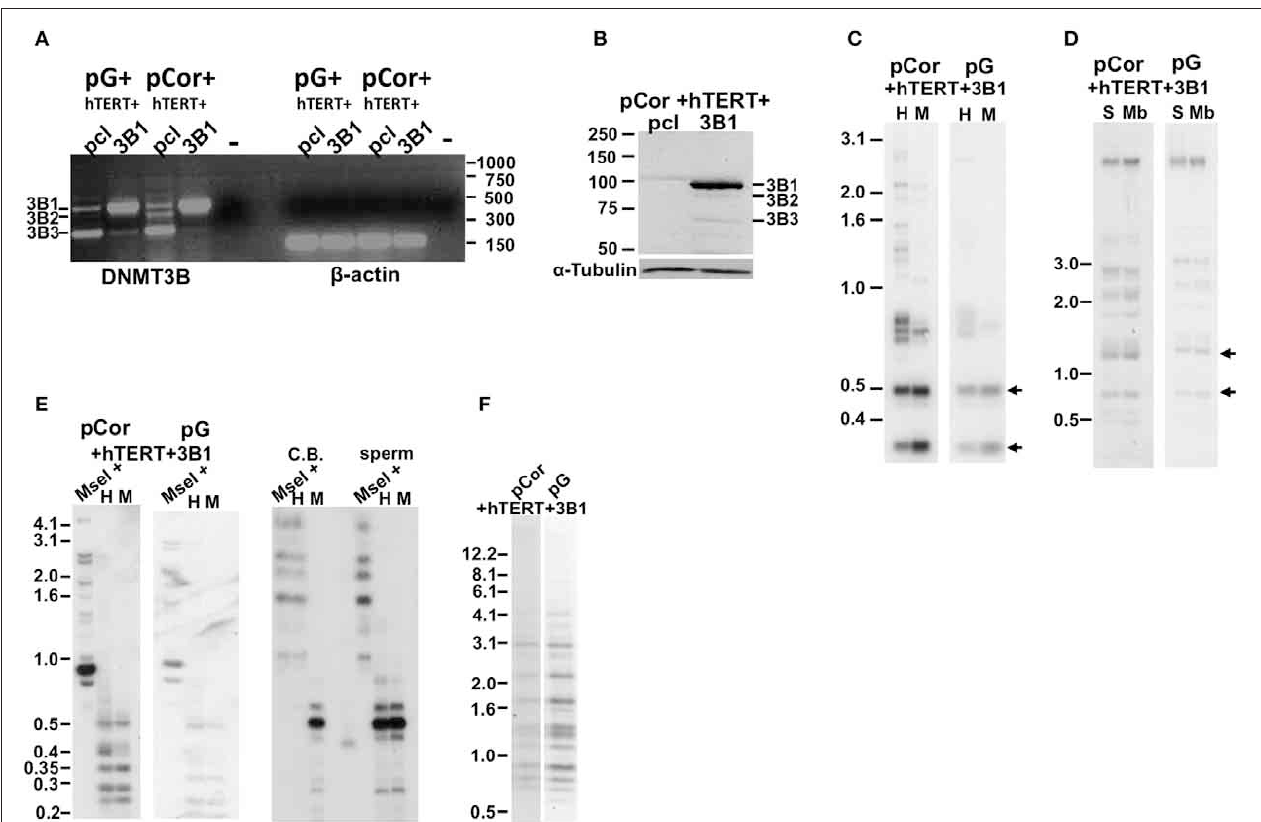
FIGURE 6 | The abnormal methylation state of subtelomeric regions and other non-telomeric repetitive sequences is not rescued by human DNMT3B1 in ICF fibroblasts. (A) RT-PCR analysis of DNMT3B1 mRNA expression in immortalized pG and pCor fibroblasts introduced with either an empty plasmid as a control (pcl) or DNMT3B1 (3B1). DNMT3B has several isoforms as a result of alternative splicing. The most prevalent isoforms are: DNMT3B1 (3B1), DNMT3B2 (3B2), and DNMT3B3 (3B3). The full-length 3B1 is highly expressed only in the immortalized ICF fibroblasts that have been transduced with the full-length cDNA. Size markers in kb appear to the right of the gel. β -actin was amplified as a control. (B) Western blot analysis of DNMT3B expression in immortalized pCor fibroblasts, which were transduced with either the empty plasmid (pcl) or hDNMT3B1 (3B1). DNMT3B1 (3B1) appears clearly only in the cells introduced with the full-length isoform of DNMT3B. Size markers in KD appear on the left of the blot. α -Tubulin serves as a control for equal protein loading. (C) Methylation analysis of pCor + hTERT + DNMT3B1 and pG + hTERT + DNMT3B1 fibroblasts with the subtelomeric NBL-1 probe following digestion of DNA samples with HpaII (H) and MspI (M).